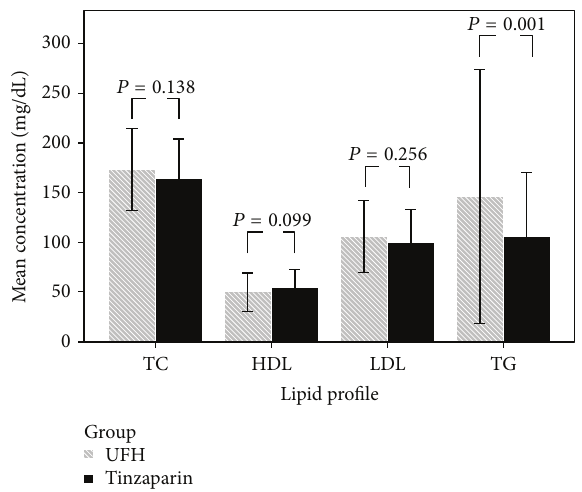
Figure 1: Differences in the lipid profiles between patients receiving conventional unfractionated heparin (UFH) or tinzaparin. Triglyc- eride was significantly different between the two groups ( 𝑃 = 0.001 ), but total cholesterol (TC), high-density lipoprotein (HDL), and low- density lipoprotein (LDL) showed no significant